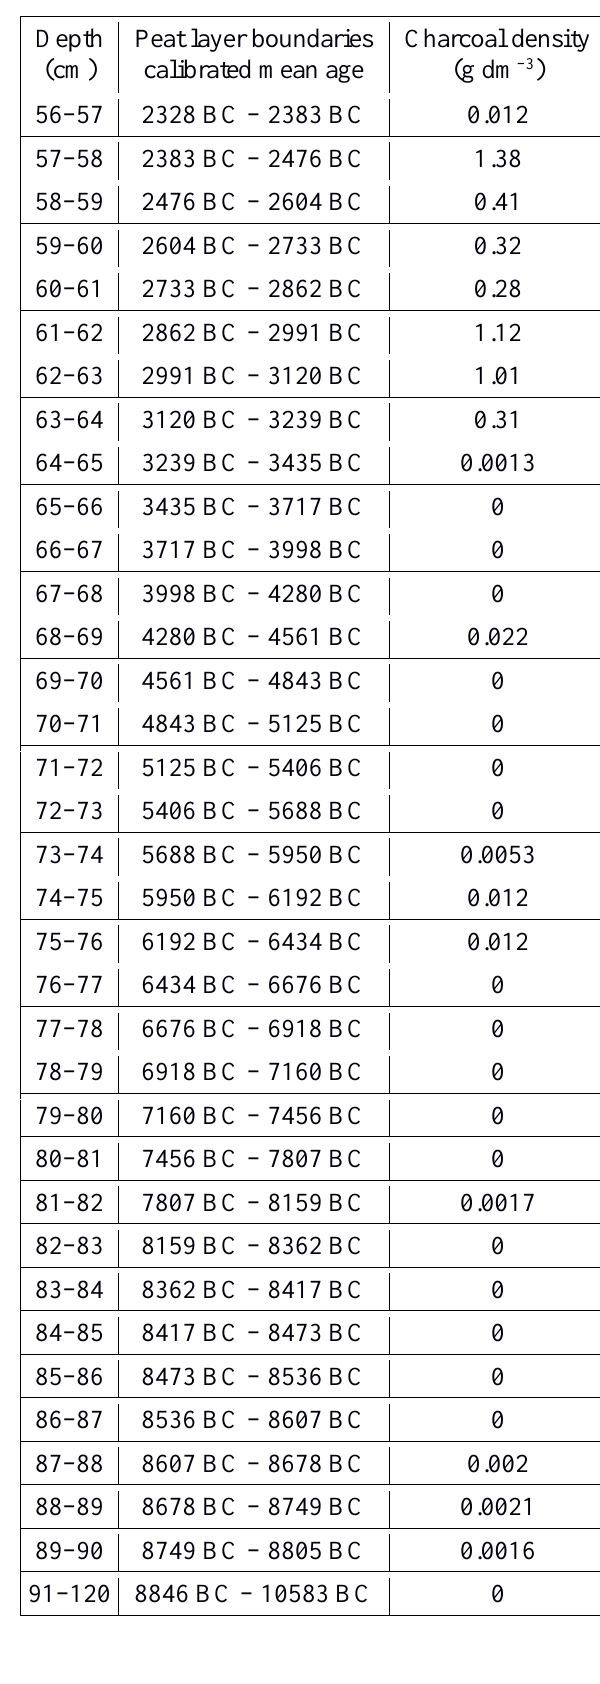
Table 3. Mass of charcoal per unit of volume in peat core Żyglin